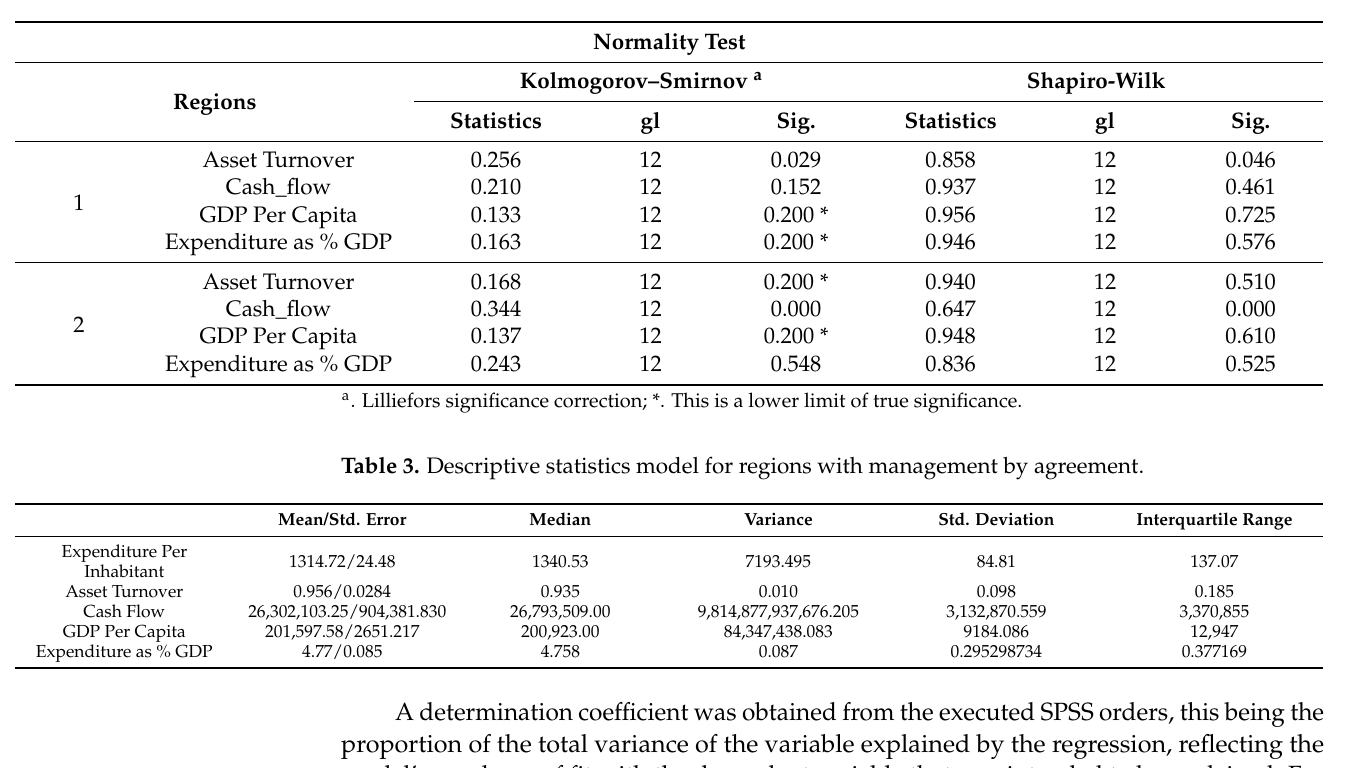
Table 2. Normality test. Region 1 with management by agreement. Region 2 with direct management.